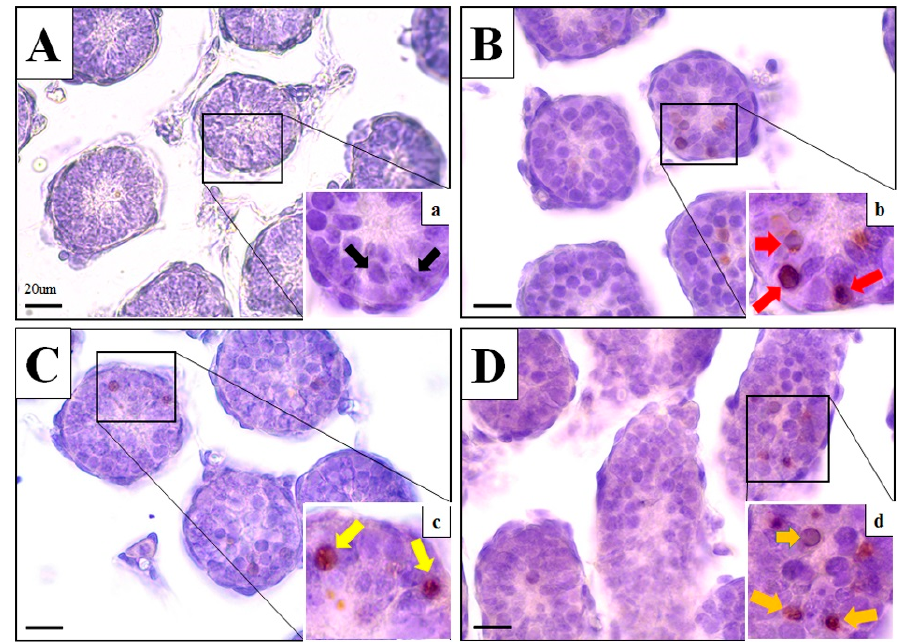
Figure 3. TUNEL-positive cells in testicular sections from control and maternal restraint stressed males. ( A ) Control testes; ( B ) MRS; ( C ) MRS + 2 mg/kg; and ( D ) MRS + 20 mg/kg seminiferous tubules. Magnification in panels ( A – D ) 400×; magnification in (a), (b), (c), and (d) 1000×.